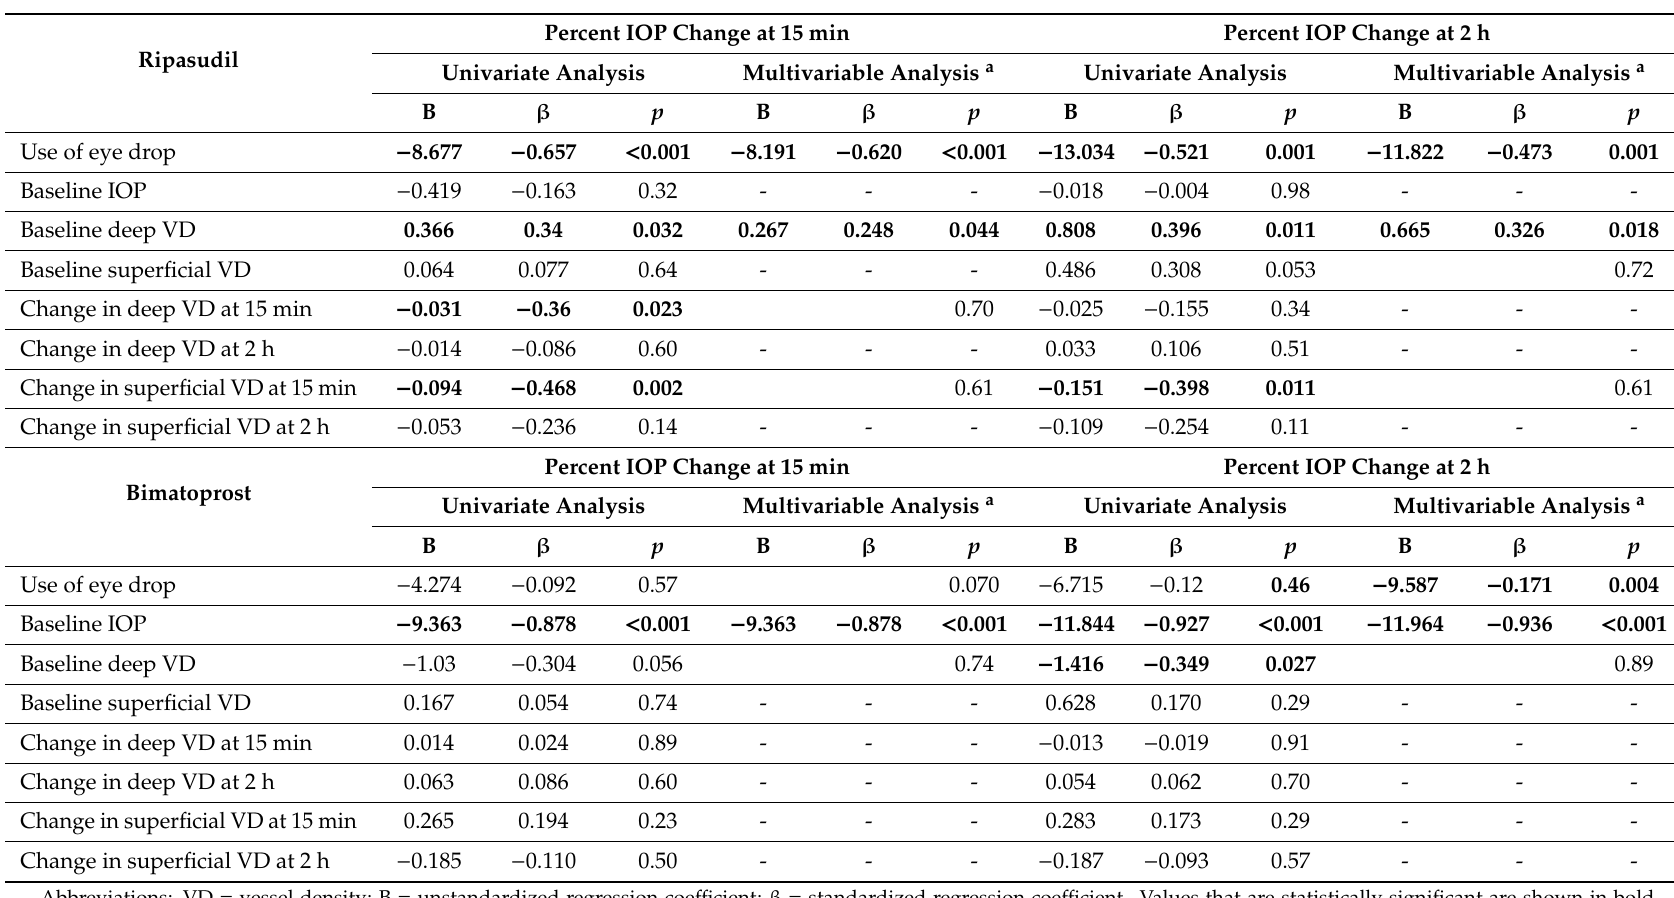
Table 3. Factors associated with the percent changes in intraocular pressure